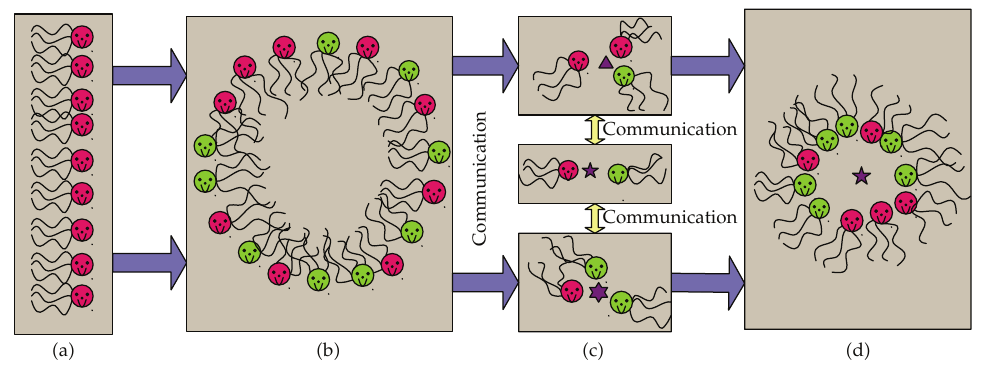
Figure 1: Individual and social behavior of artificial